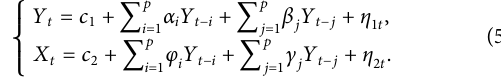
consumption, and breaks down the technology level factor in the STIRPAT model into social industrial structure δ 1, energy